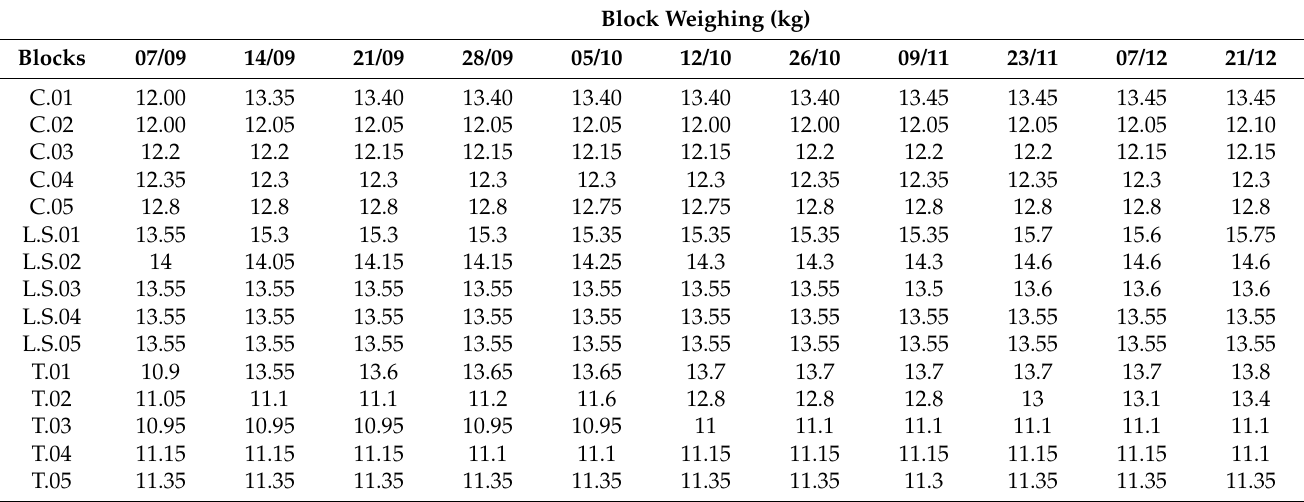
Table 6. Weighing data of the three blocks, from 7 September to 21 December.